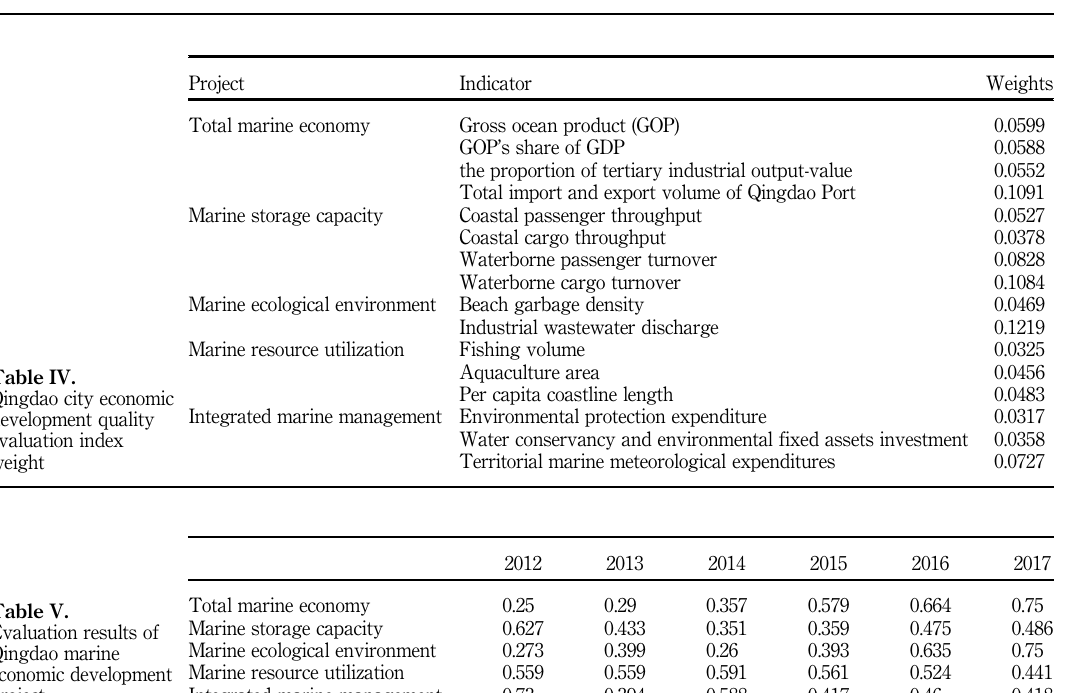
Table III. Normalization evaluation data for all indexes